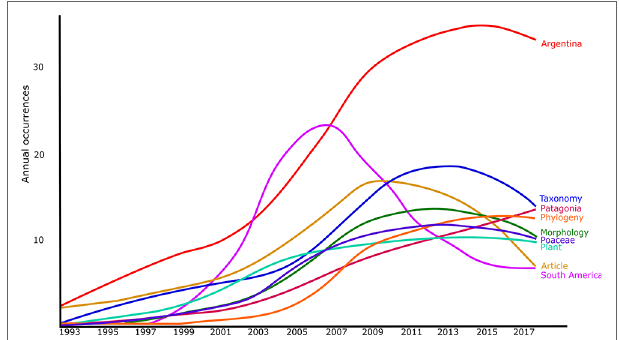
FIGURE 2 | The tendency along time of the occurrence of the nine most frequent words in the abstract and/or title of herbaria-based-research articles, based on the bibliometric analysis of publications stored at Scopus database from 1993 to 2018 (refer to the text to see filters of the search).